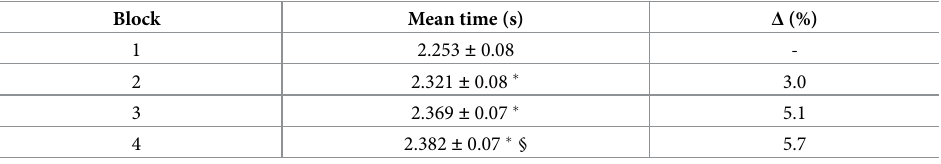
Table 1. Mean times (s) ± SD of RA blocks, and % difference between each block and the 1 st one.